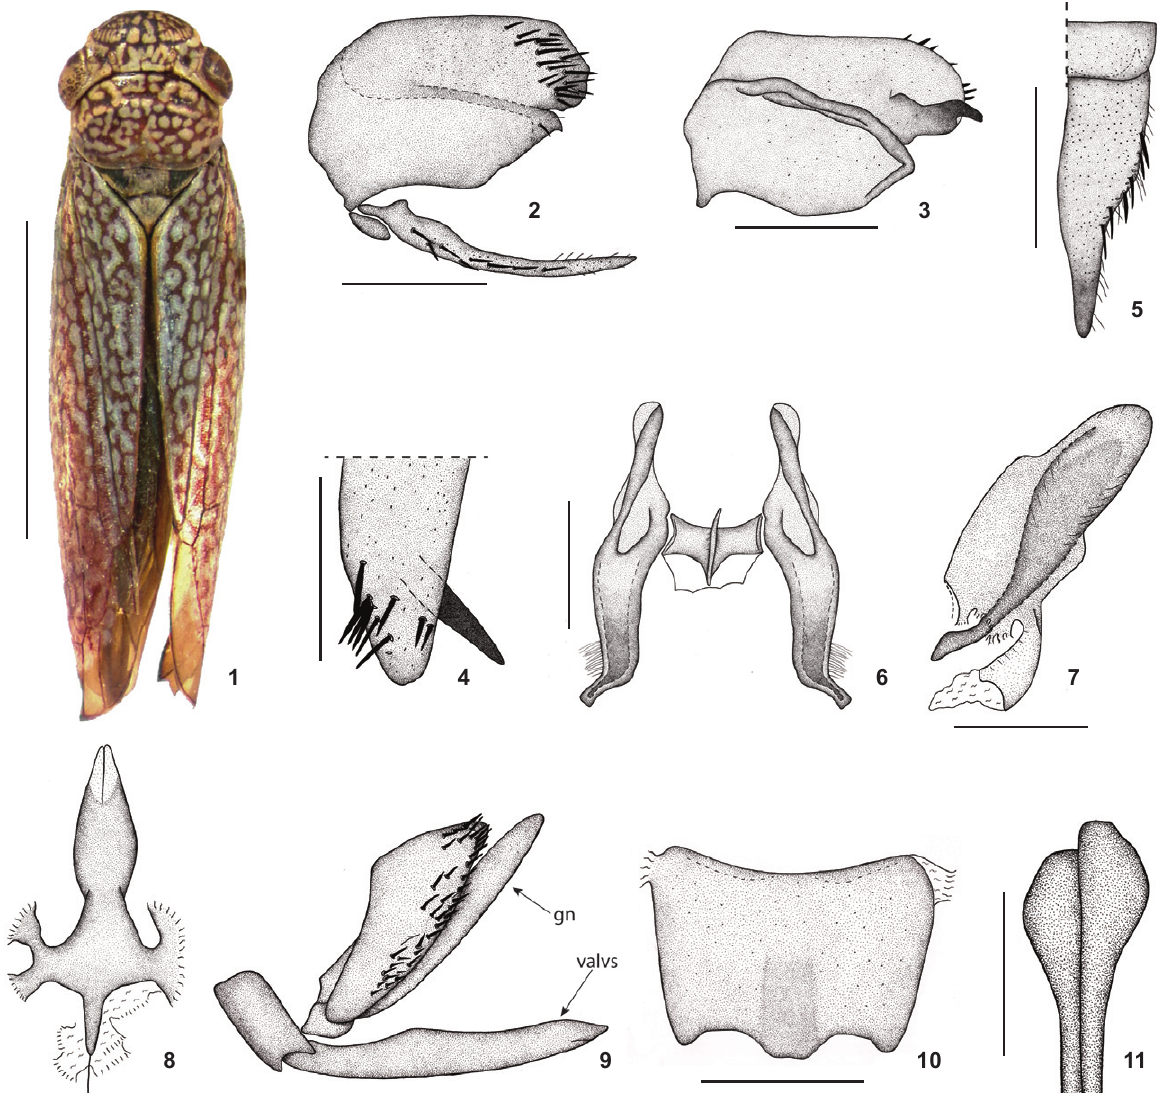
lines. Mesonotum with pair of dark triangular maculae near basolateral angles. Male genitalia. Pygofer lobes with process arising from internal surface anteapically (Figs 2-4); macrosetae distributed at apical third; apex truncate. Subgenital plates extending pos- teriorly beyond pygofer apex; with uniseriate macrosetae and microsetae on lateral margin (Fig. 5). Connective Y-shaped